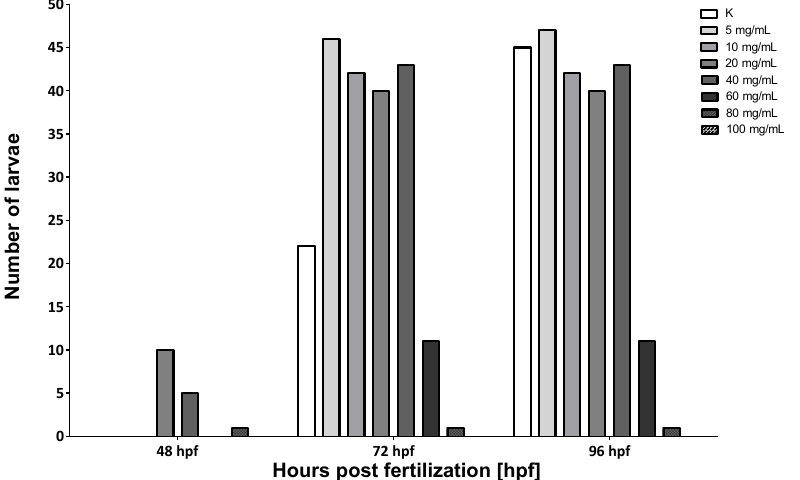
Figure 4. Results of the effect of MI on the zebrafish hatching. Ctr–control group; zebrafish embryos were treated with different concentrations of MI solutions from 5 to 100 mg/mL. Effect of different concentrations of MI were observed at time 48, 72, and 96 h post-fertilization (hpf).